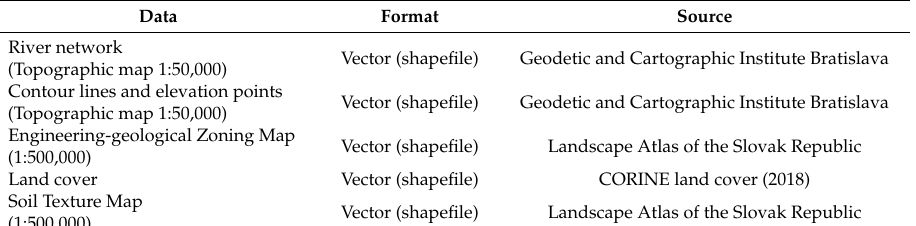
Table 1. Data sources used for processing of flood conditioning factors.